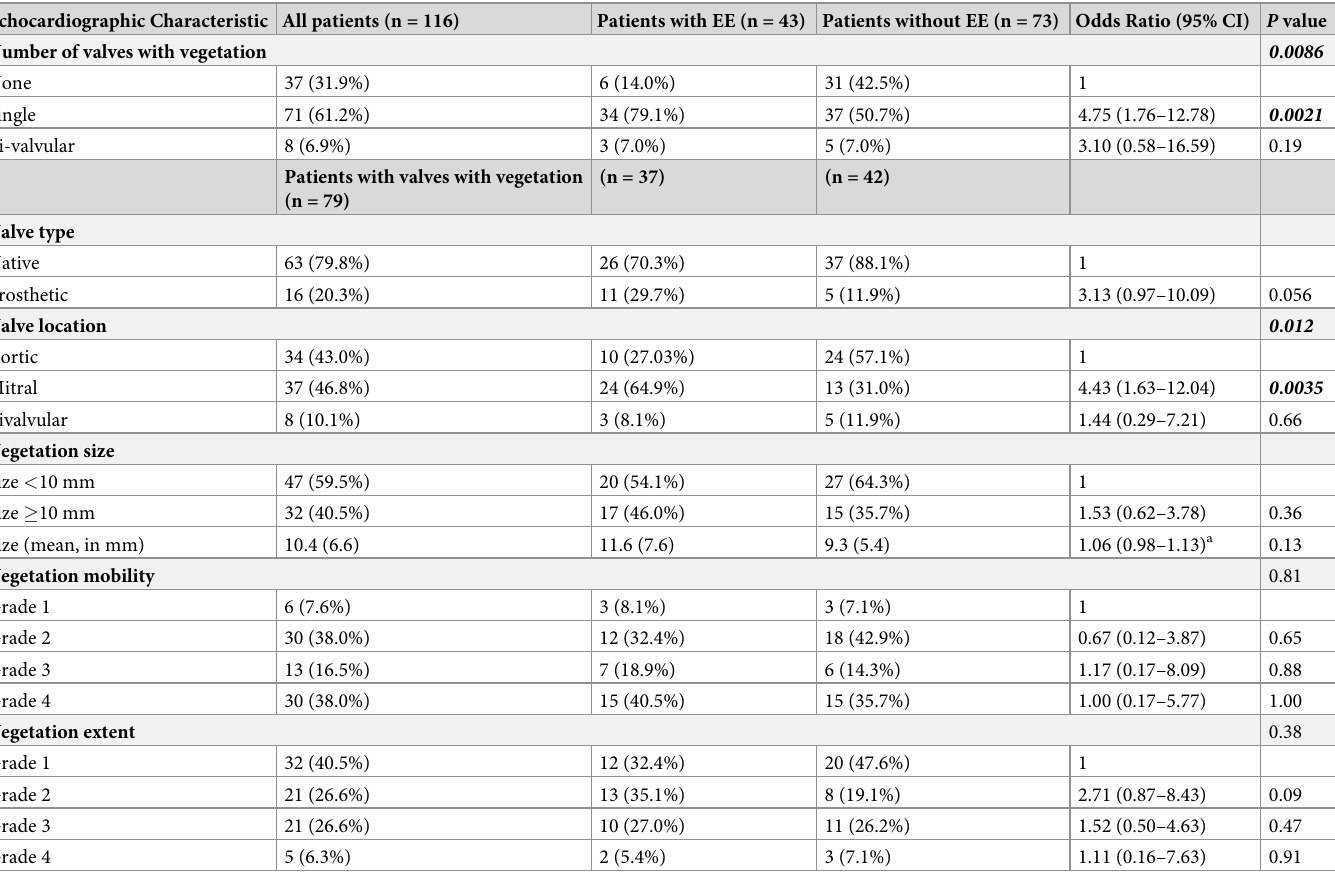
Table 2. Echocardiographic characteristics of patients with an embolic event occurring at any time. Echocardiographic Characteristic All patients (n =